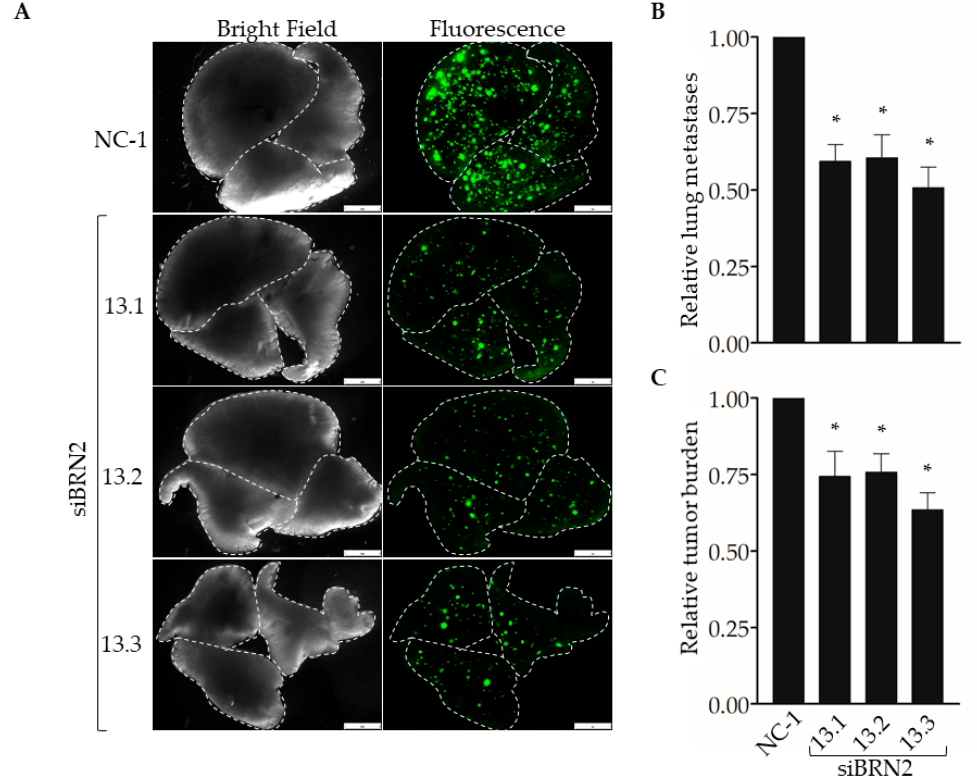
Figure 6. RNAi-targeting of BRN2 decreases lung colonization by MDA-MB-231 cells. A total of 5 x 10 4 cells stably transduced with ZsGreen and transiently expressing either non-targeting dicer-substrate siRNA (NC-1) or BRN2 -targeting dicer-substrate siRNA (si BRN2 13.1, 13.2, or 13.3) were injected into tail-veins of NSG™ mice. ( A ) Representative bright-field or fluorescent (ZsGreen) images of lungs harvested from mice 14 days post-injection. Dashed lines outline individual lobes. ( B , C ) Graphs show ( B ) relative lung metastases and ( C ) tumor burden in lungs of mice injected with control or Brn-2 knockdown cells; x -axis labels in ( C ) apply to (B); n = 7 per group; mean +/ − SEM; * p < 0.05; two-tailed t -test with Bonferroni correction; scale bar, 2